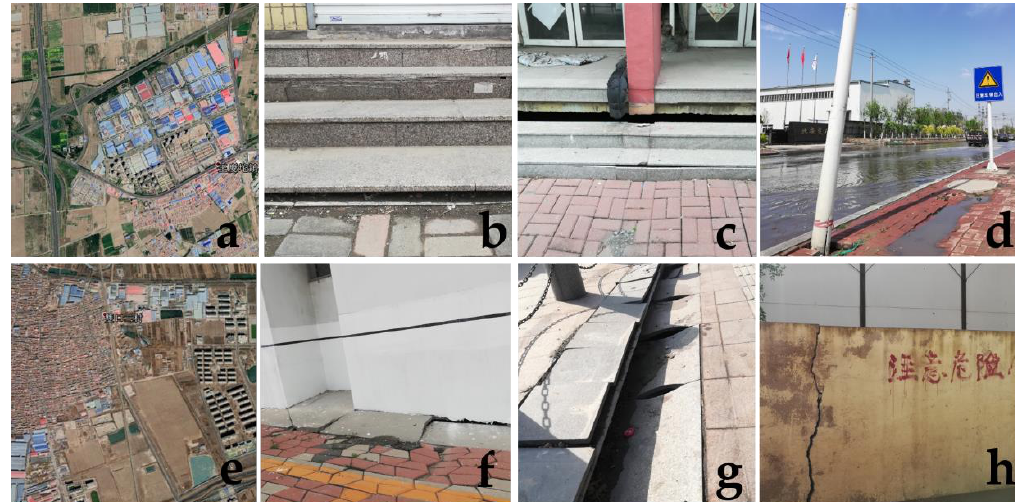
Figure 5. ( a – d ) The Google Earth image and photos of ground subsidence in Wangqingtuo town, located in the high subsidence area; ( e – h ) the Google Earth image and photos of ground subsidence effects in Hebei University of Technology, located in the medium subsidence area.